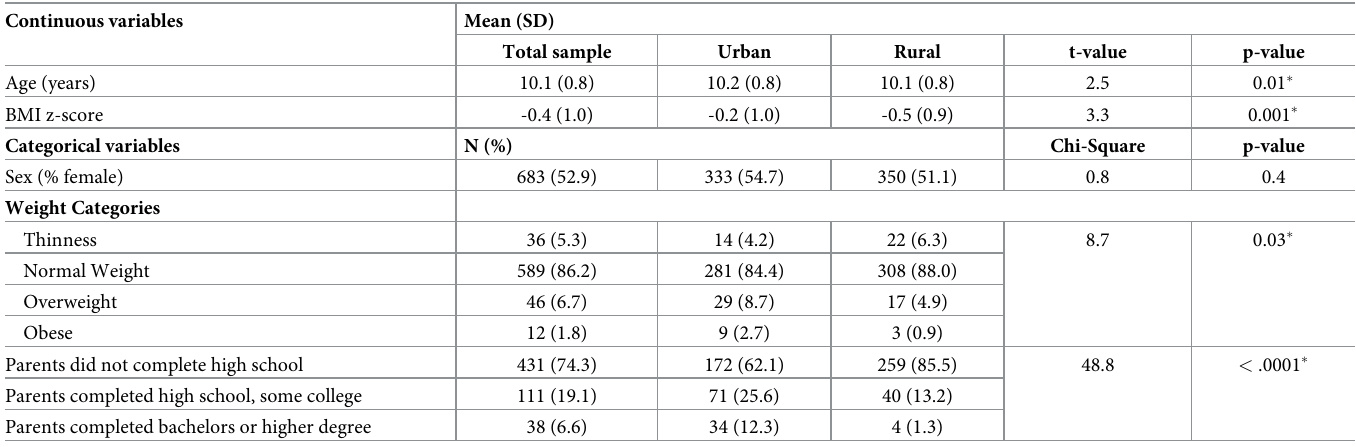
Table 2. Descriptive characteristics (n =